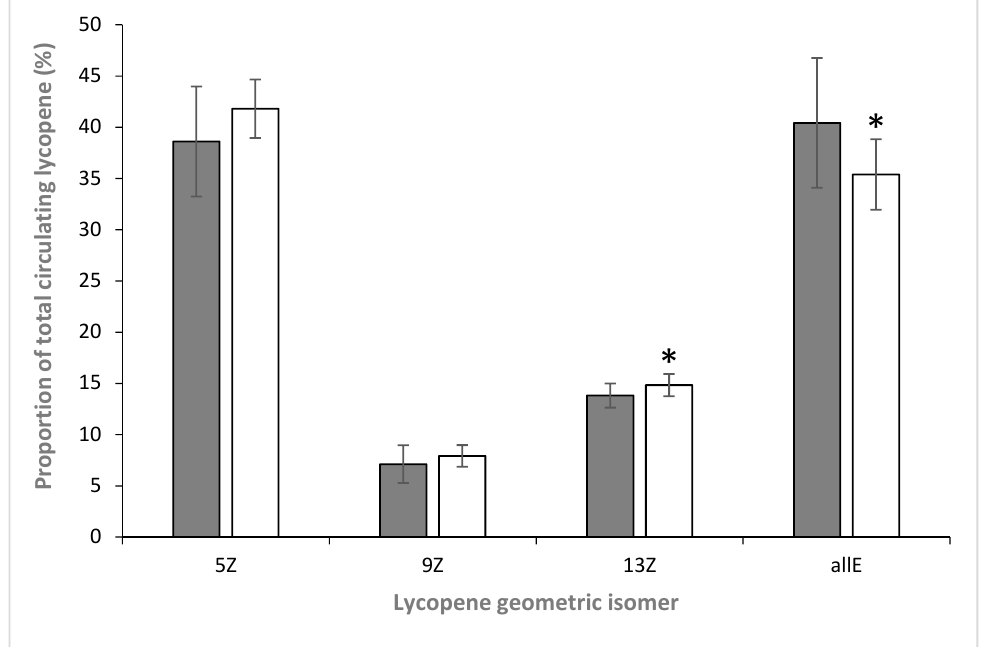
Figure 3. Changes in the relative amounts of individual geometrical isomers of lycopene, expressed as a percentage of total circulating lycopene in smokers (clear) and non-smokers (shaded). n = 52 ± SD * indicates significant differences between smokers and non-smokers ( p < 0.05). Table 3. On-line spectral characteristics and retention times, determined by diode-array detection (in the range of 200–600 nm) using HPLC separation with a C30 reversed-phase column (see Graham et al. [18] for further details). λ max —wavelength of the main absorption bands; A B /A II —the relative intensities of the heights of the cis -peak and the middle absorption band ( λ max ); T R —the retention time. Geometric Isomer λ max (nm)